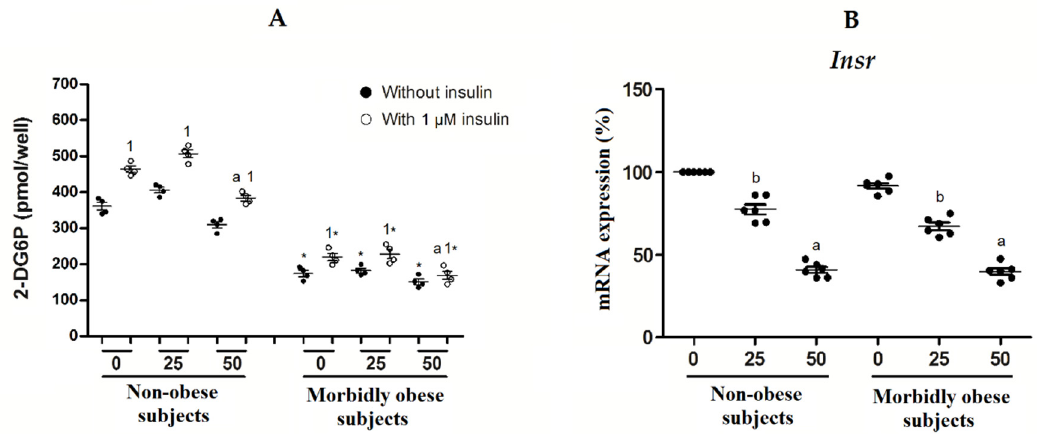
Figure 3. ( A ) Glucose uptake in human visceral in vitro di ff erentiated adipocytes obtained from HMSC from non-obese ( n = 4) and morbidly obese subjects ( n = 4) incubated with 0, 25, and 50 µ g / mL of oxLDL for 24 h. a p < 0.05: significant di ff erences between 50 µ g / mL with 0 and 25 µ g / mL oxLDL. 1 p < 0.05: significant di ff erences with regard to its control (non-insulin treated). * p < 0.05: significant di ff erences for each dose between non-obese and morbidly obese subjects; ( B ) levels of mRNA expression of insulin receptor ( Insr ) in human visceral in vitro di ff erentiated adipocytes obtained from HMSC from non-obese ( n = 6) and morbidly obese subjects ( n = 6) incubated with 0, 25, and 50 µ g / mL of oxLDL for 24h. a p < 0.05: significant di ff erences between 50 µ g / mL with 0 and 25 µ g / mL oxLDL. b p < 0.05: significant di ff erences between 0 and 25 µ g / mL oxLDL.